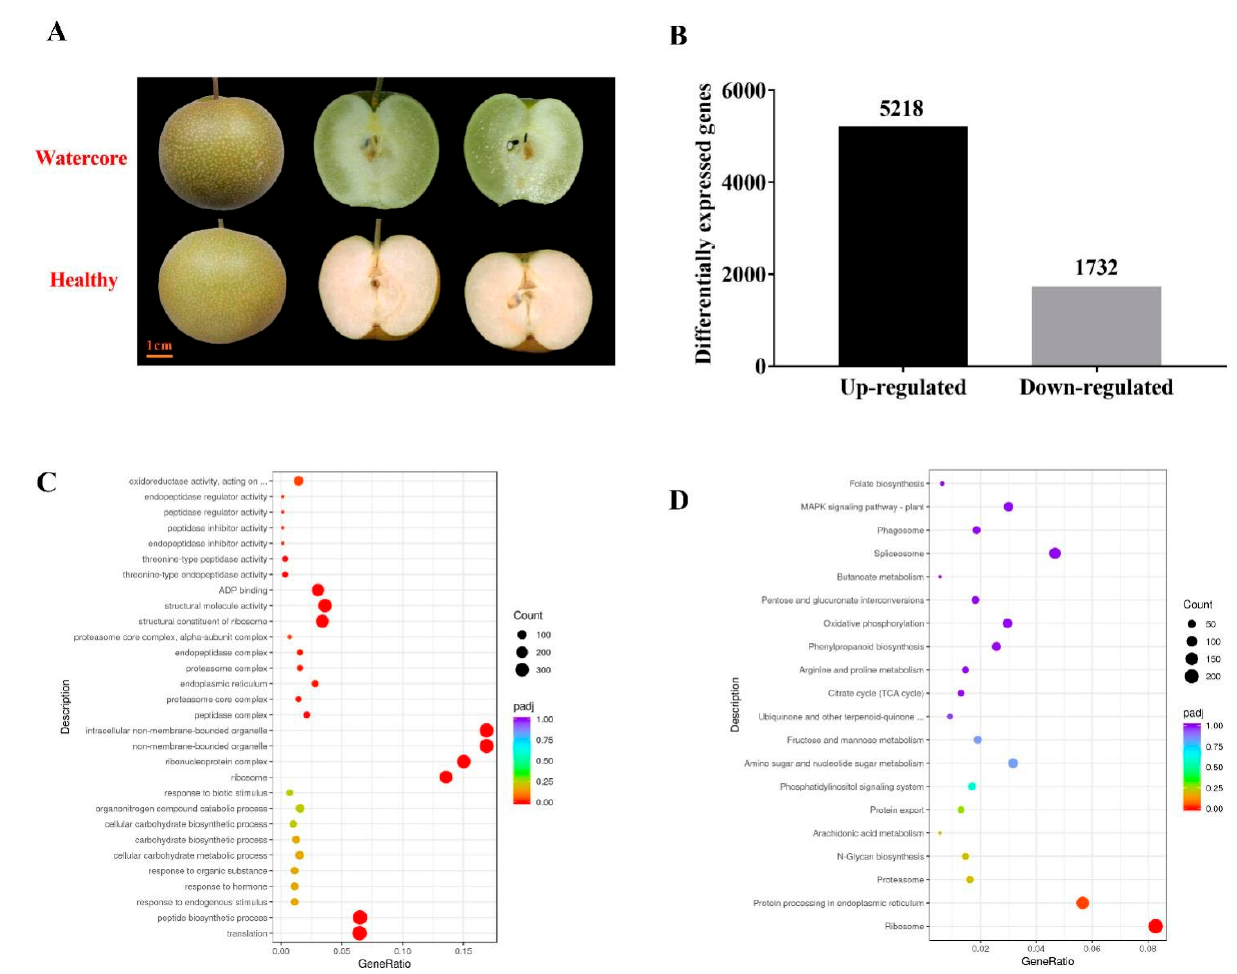
Figure 1. Watercore symptoms, number of DEGs, GO classification and KEGG enrichment of DEGs. ( A )“Akibae” watercore symptoms; ( B ); Number of DEGs; ( C ) GO classification; ( D ) KEGG enrichment of DEGs. Table 1. Statistics of sequencing data of the all libraries. Table1 Statistics of Sequencing Data of the Six Libraries